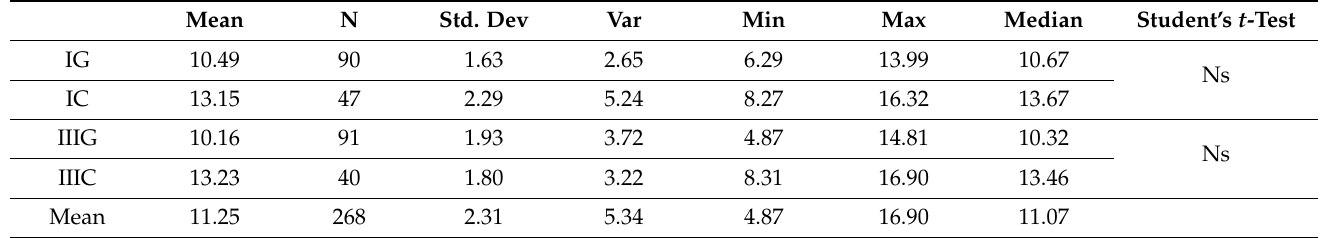
Table 6. Basic statistical parameters for the strength-to-density coefficient [km] and results of the Stu- dent’s t -test for samples collected from the ground section (G) and breast height (C) from both